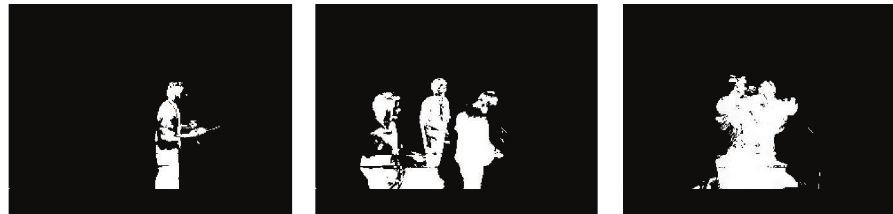
Figure 9: MHI of three different activities: single normal, multiple normal, and multiple abnormal (left to